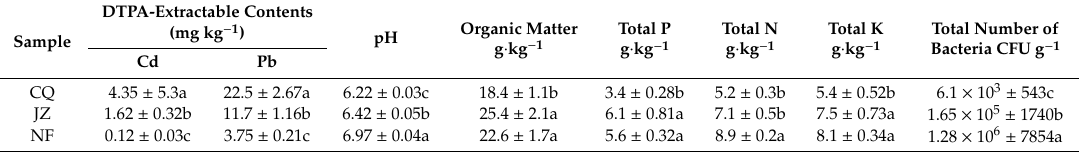
Table 1. Physical and chemical properties of three water spinach rhizosphere soil samples (x ± s).